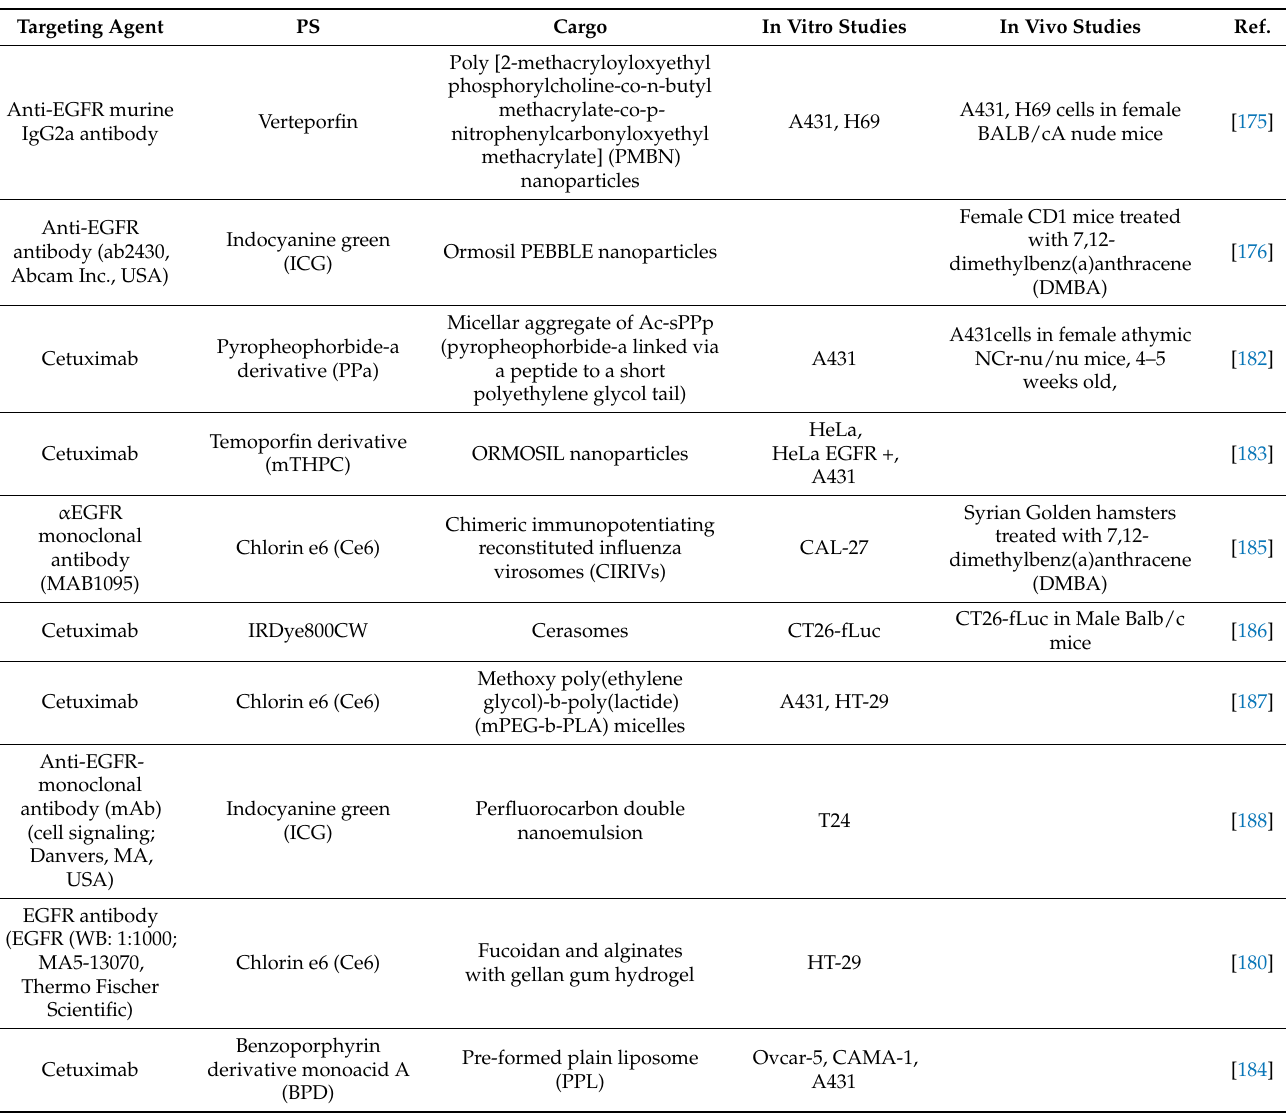
Table 8. EGFR-targeted PDT performed with anti-EGFR antibodies conjugated with carrier molecules. Targeting Agent PS Cargo In Vitro Studies In Vivo Studies